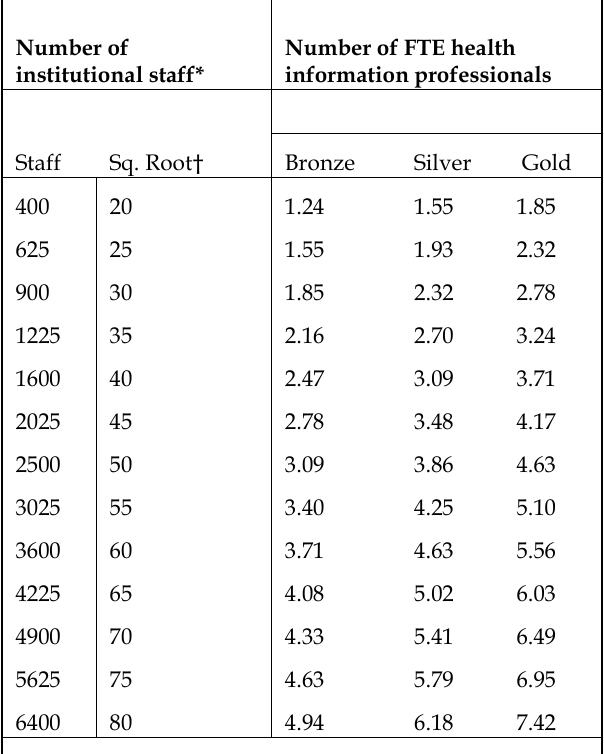
Table 1 Staffing grid by HSICT level of